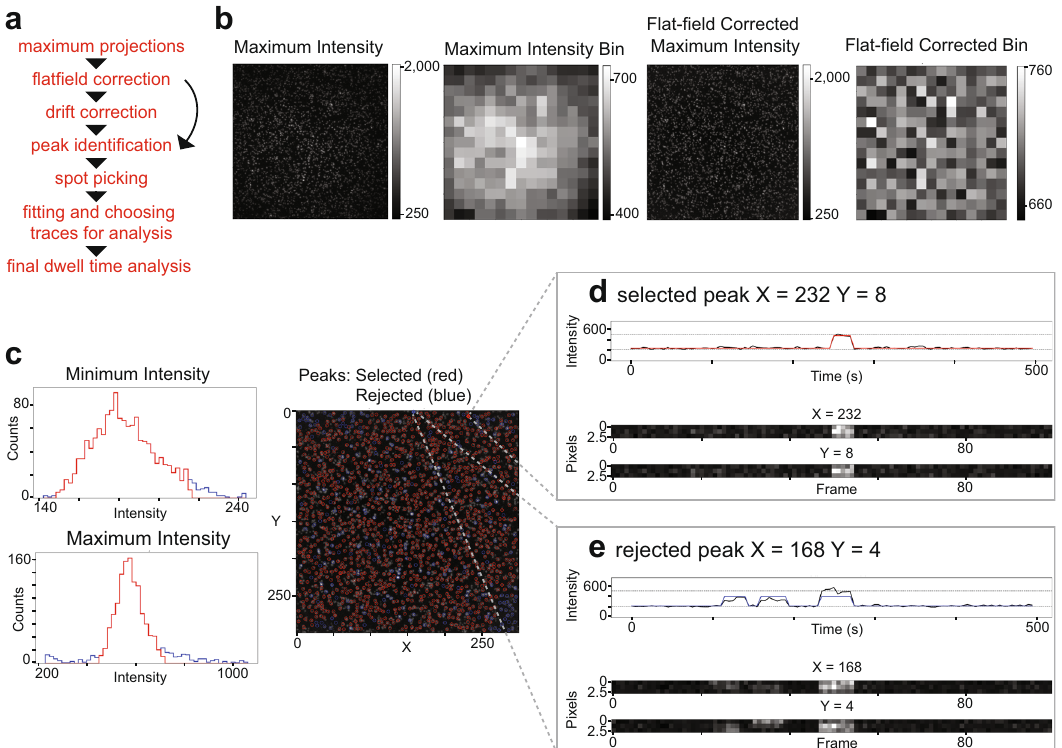
Fig. 3 SMOR analysis. a Analysis pipeline for SMOR analysis. b For fl at- fi eld correction, the maximum intensity projection of a 300 × 300 pixel movie is binned into a 20 × 20 pixel grid, fl at- fi eld corrected, and then binned again to check correction. c Histograms of minimum and maximum intensity values along traces for each peak. Red indicates selected peaks ( ≤ 3 SD from median) and blue indicates rejected peaks. At right is a maximum intensity projection with selected (red circle) and rejected (blue circle) peaks ( x , y coordinates). d Representative single-molecule trace of a selected peak at coordinates (232, 8). e Representative single-molecule trace of a rejected peak at coordinates (168,